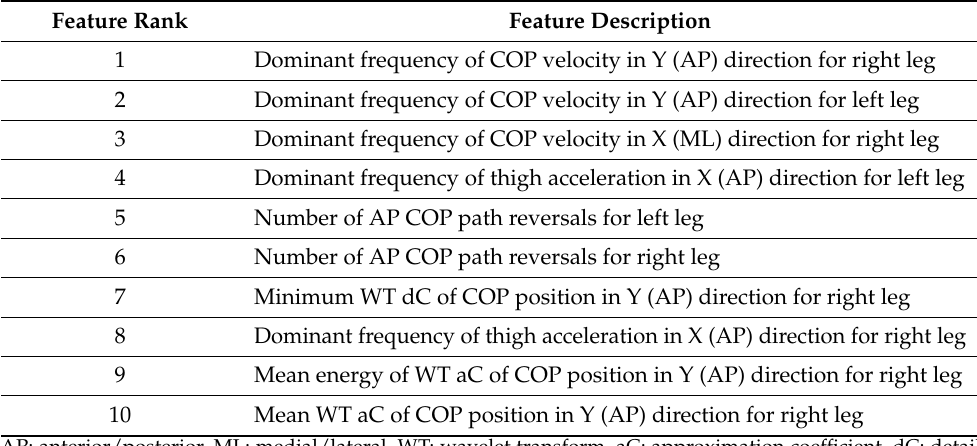
Table 5. Top 10 features (according to Relief-F) used in the plantar pressure and IMU (PP-IMU) features model.